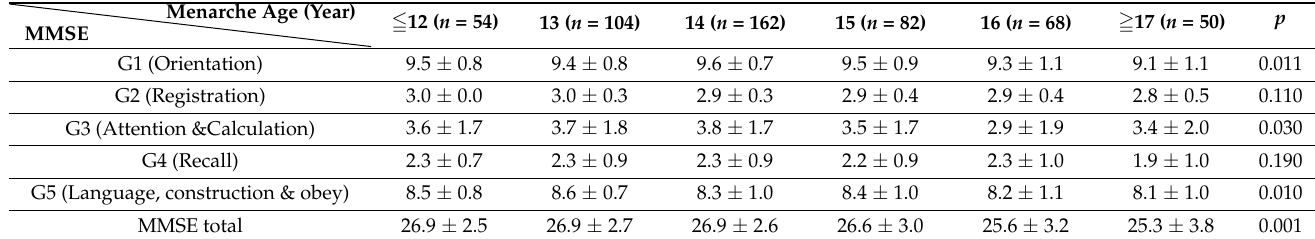
Table 3. Comparison of MMSE total and subscores according to age of